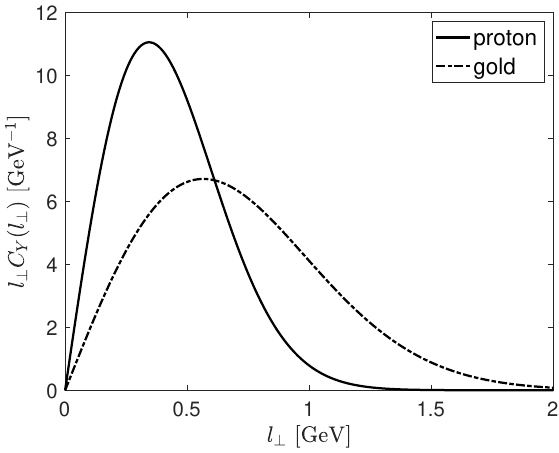
Figure 2 . Proton and gold dipole correlators in momentum space at the initial rapidity Y = 0 prior to rcBK evolution with Y . The nuclear dipole correlator is broader and peaked at a larger value of momentum relative to the proton dipole correlator. Note that in our convention for the Fourier transform we have R C Y ( l ⊥ ) = 1 l ⊥